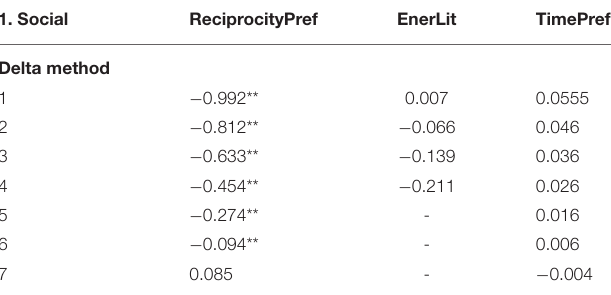
TABLE 7 | Conditional marginal effects of energy-related preferences.